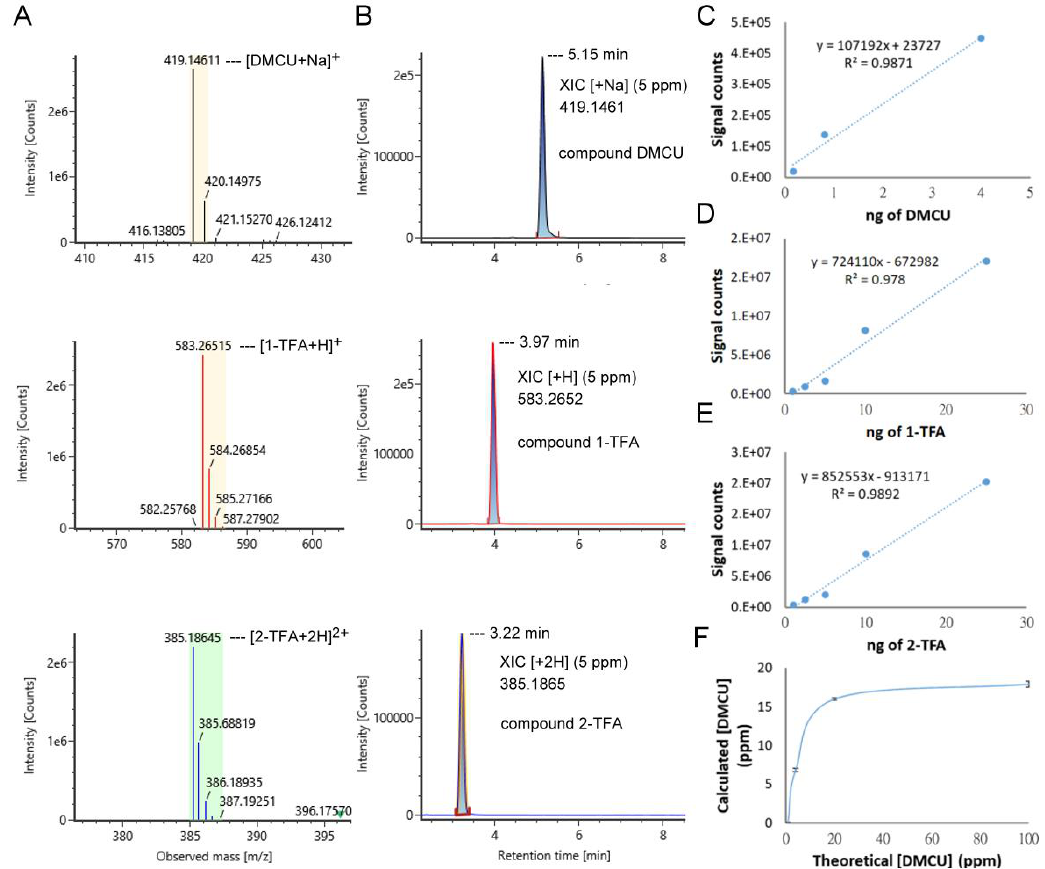
Figure 3. Quantification of water solubility of DMCU , 1-TFA , and 2-TFA . ( A , B ) Mass spectrum ( A ) and extracted ion chromatograms (XIC) ( B ) of DMCU , 1-TFA , and 2-TFA . ( C – E ) Calibration curves of DMCU (C) , 1-TFA ( D ), and 2-TFA ( E ). ( F ) An investigation on the water solubility of DMCU . The solubility of all compounds was determined at room temperature.